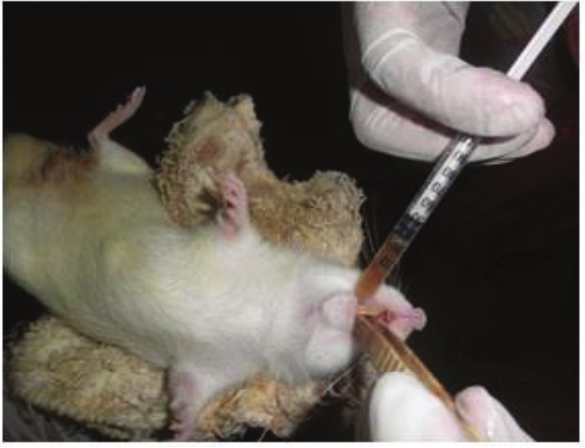
Fig-1: Rat readily drinking sweetener solution (1 gm/kg) by the oral syringe-dosing Statistical